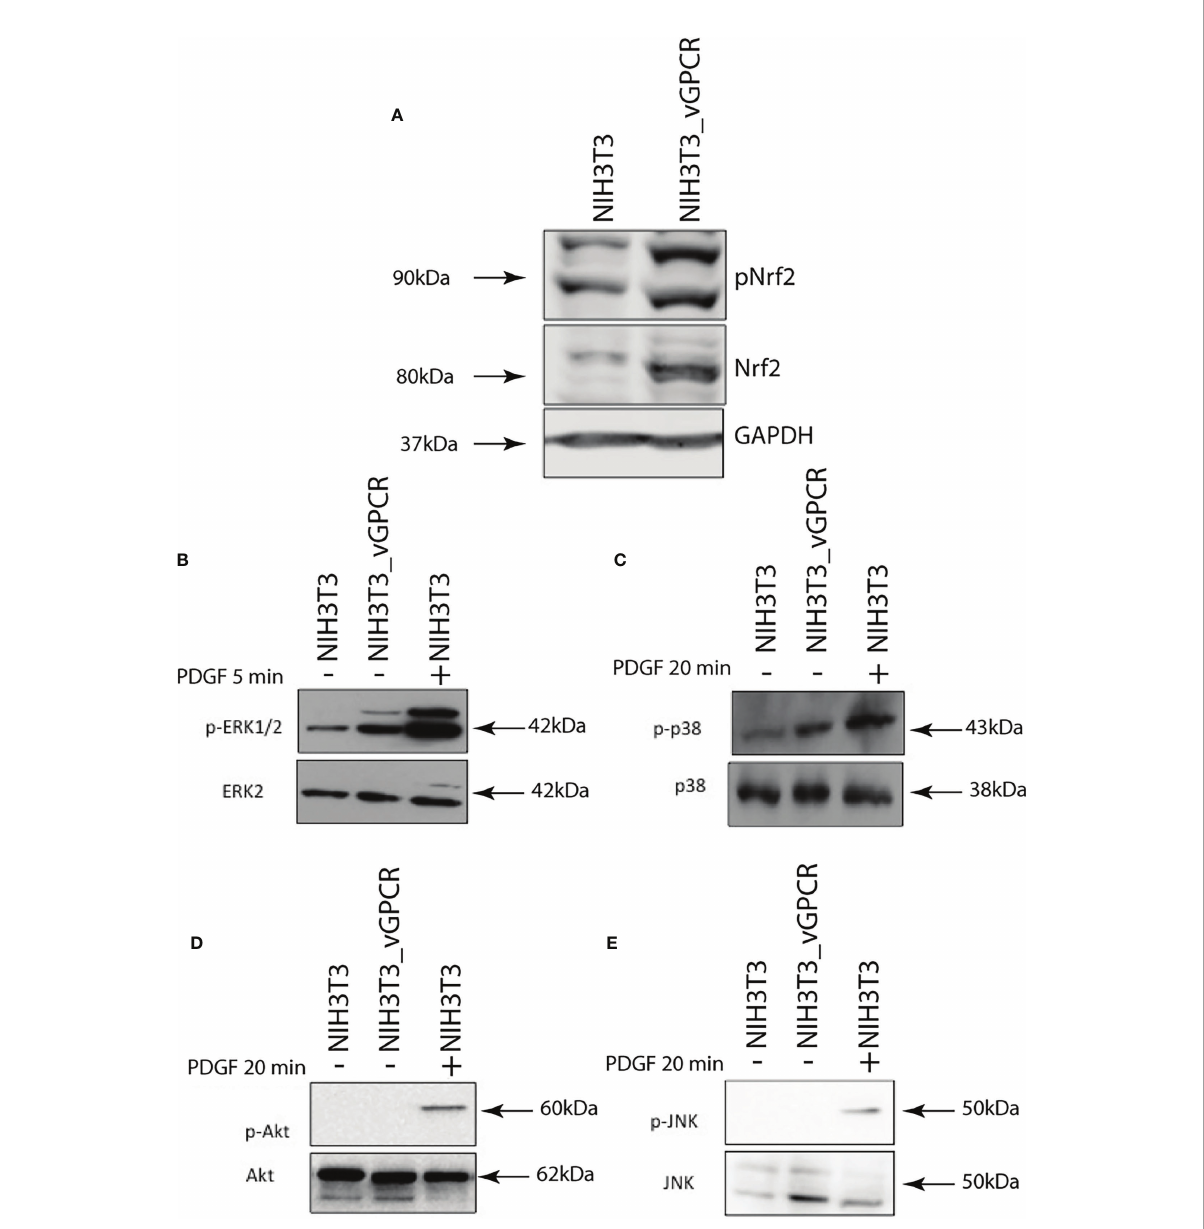
FIGURE 4 (A) Western Blot Assays performed in NIH3T3 and NIH3T3_vGPCR were evaluated for Nrf2 levels and Nrf2 phosphorylation using anti-phospho Nrf2 and anti- Nrf2. As loading control we used GAPDH. (B) Western Blot Assays performed in lysates of NIH3T3 and NIH3T3_vGPCR cells